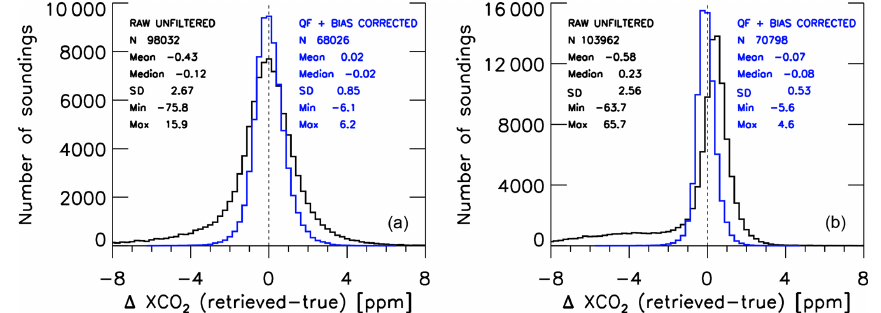
Figure 17. Histograms of the error in XCO 2 (retrieved – true) at 0.25ppm resolution for land (a) and water (b) for the full year of simulations. The raw, uncorrected XCO 2 values are shown in black, while the filtered and bias-corrected values are shown in